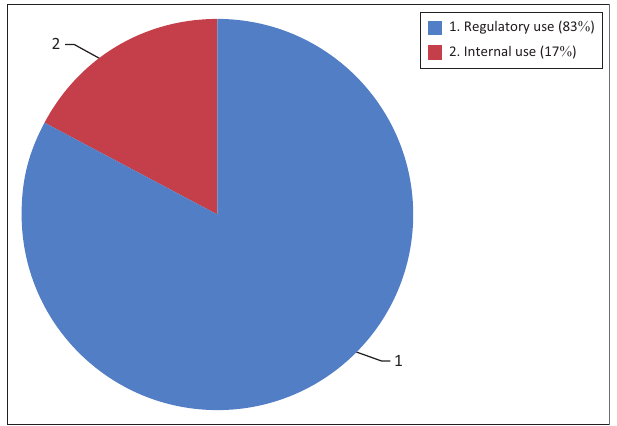
FIG URE 7: Calculation of economic